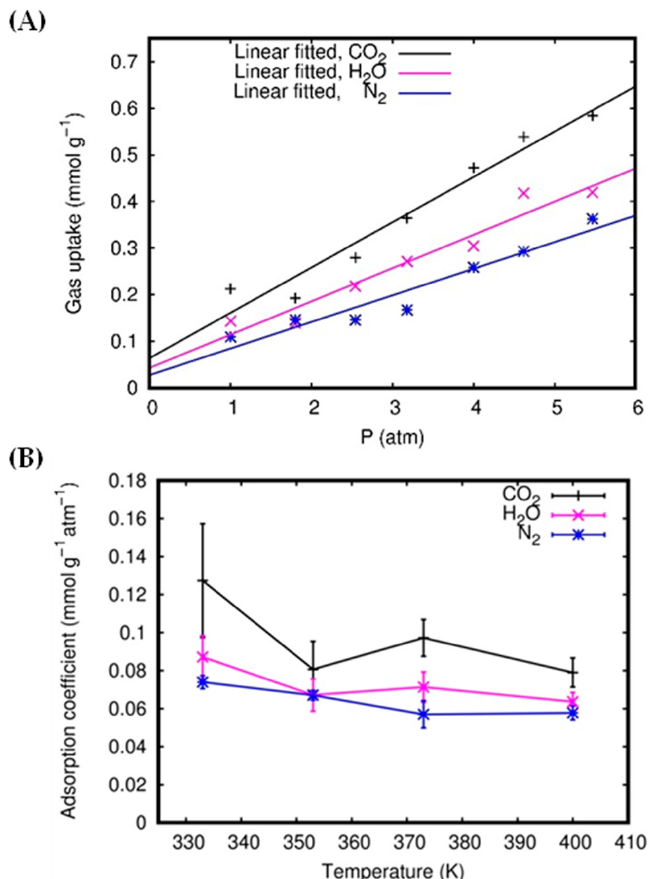
Figure 8. Single-layer system: the adsorption isotherms at 373 K ( A ) and adsorption coefficients as a function of temperature ( B ).